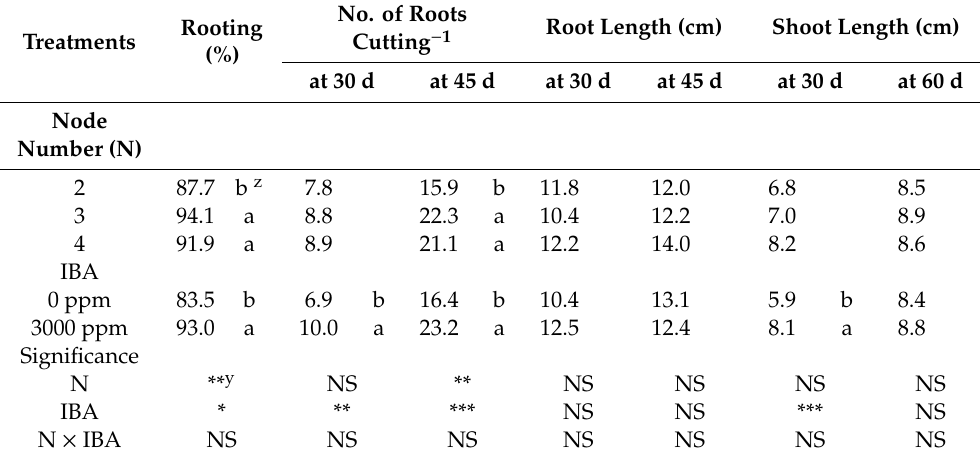
Table 1. E ff ects of number of nodes per cutting and indole-3-butyric acid (IBA) on rooting and shoot length of Nerium oleander